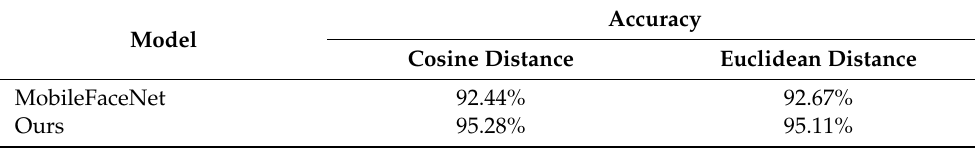
Table 4. Results of a comparison with facial recognition